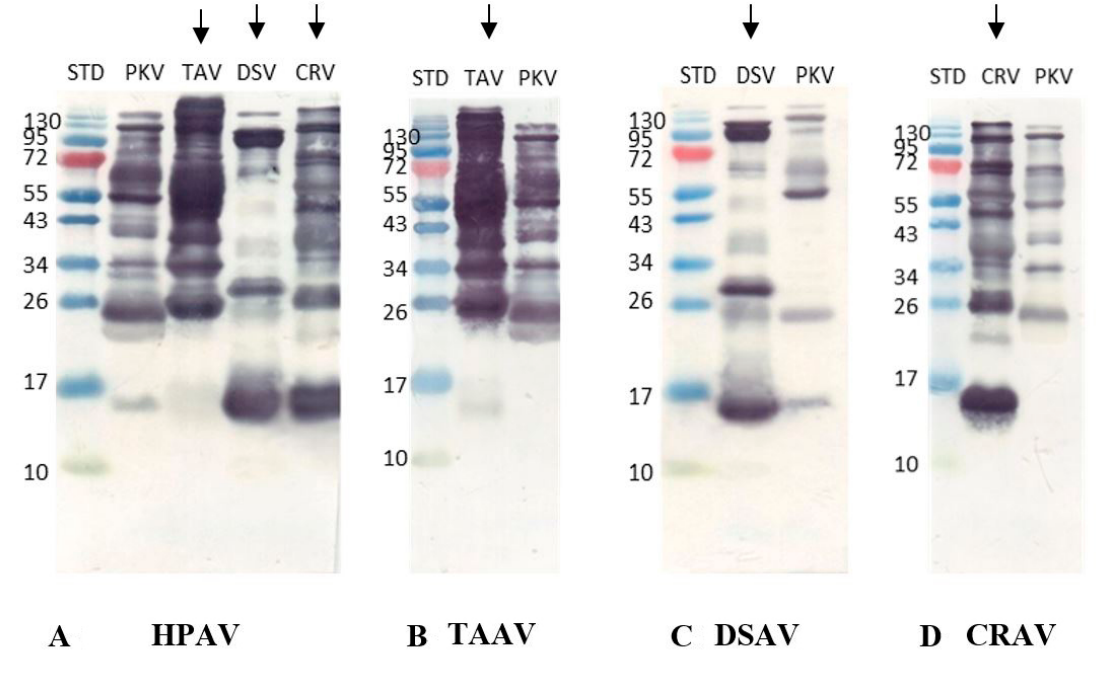
Figure 3. Western blot profiles of Protobothrops kelomohy venom exhibited cross-reactivity with various antivenoms. (A) Immunoblotting profile of four venoms with hemato polyvalent antivenom (HPAV). (B) Immunoblotting profile of TAV and PKV with Trimeresurus albolabris monovalent antivenom (TAAV). (C) Immunoblotting profile of DSV and PKV with Daboia siamensis monovalent antivenom (DSAV). (D) Immunoblotting profile of CRV and PKV with Calloselasma rhodostoma monovalent antivenom (CRAV). Arrow symbols represent the venom of snake species used for generating the antivenom. STD: standard protein; DSV: Daboia siamensis venom; CRV: Calloselasma rhodostoma venom; TAV: Trimeresurus albolabris venom; PKV: Protobothrops kelomohy venom.